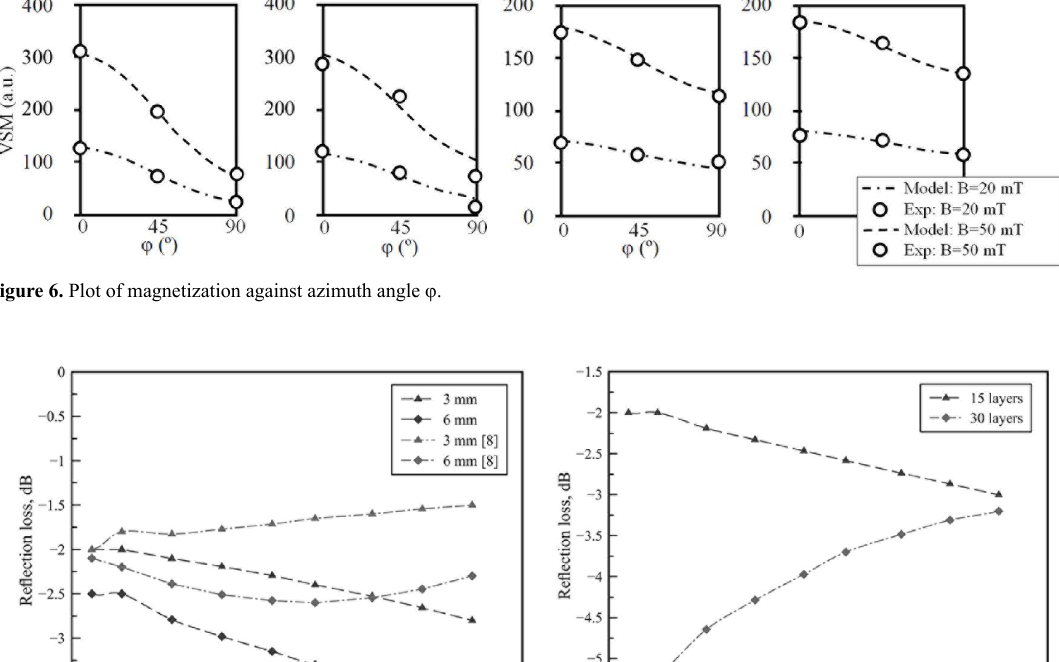
Figure 7. Microwave reflection loss RL of Fe